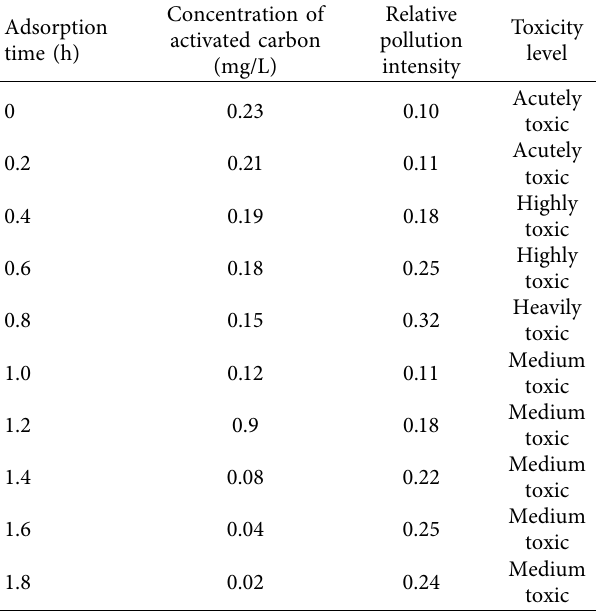
Table 7: Samples with different adsorption time of molecular toxicity of sudden ecological environmental pollution.